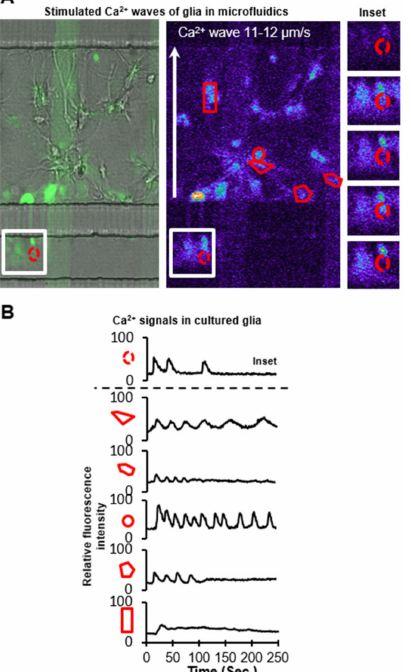
Figure 8. Ca 2+ signals of glial networks in E-PDMS microfluidics. ( A ) Primary glial cells proliferate and extend branches into adjacent microchannels through interconnects. All channels were loaded with Ca 2+ indicator (Fluo-4 AM in PBS). Glial cell branches were stimulated via 10 µ M ATP infusion ( left to right ) through stimulation channel ( bottom ). A combined brightfield and fluorescence image is shown ( left ) alongside the respective fluorescence intensity glow-scale image ( right ); FITC-PLL lines (green) on glass are reference markers. Segmented images of inset ( right ) demonstrate repeated Ca 2+ fluctuations. ( B ) Fluorescence profiles of Ca 2+ responses from respective ROI demonstrate the range of characteristic Ca 2+ responses for cultured astrocytes. Glia cultured in microdevices exhibit a typical range of Ca 2+ fluctuations that vary in frequency, amplitude, and